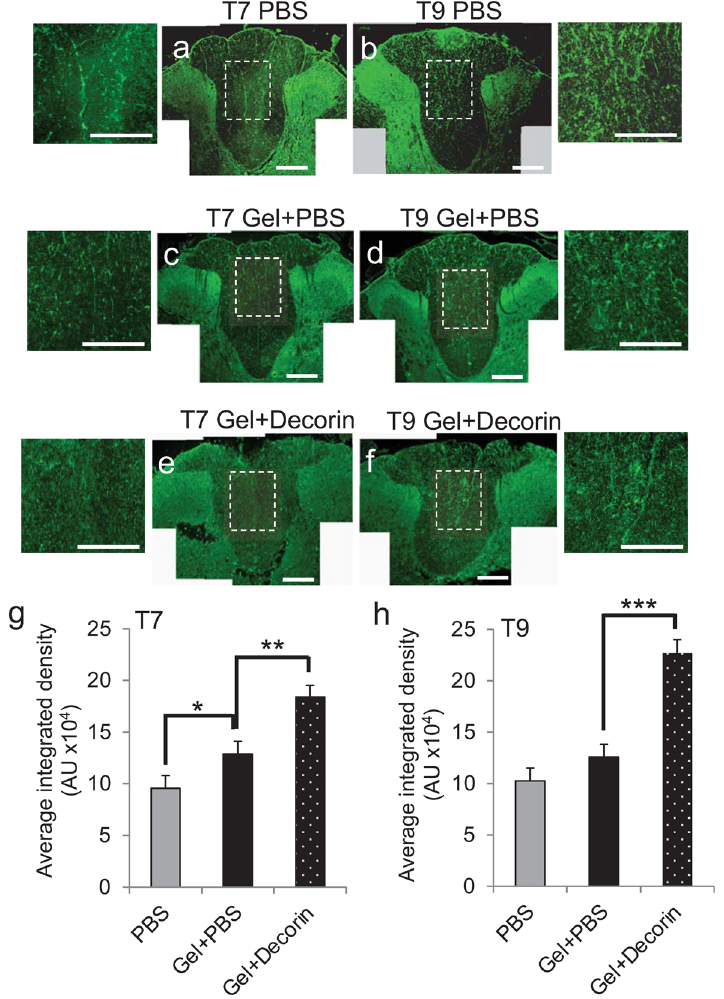
Figure 7. Gel + Decorin promotes sparing of axons above and below the lesion site. NF200 + axons after ( a ) and ( b ) PBS treatment, ( c ) and ( d ) Gel + PBS treatment, ( e ) and ( f ) Gel + Decorin in T7 and T9 cord segments, respectively. Quantification of NF200 + axons at ( g ) T7 and ( h ) T9 to show significant axon sparing in Gel + Decorin versus Gel + PBS treatment above and below the lesion site. Gel + PBS treatment alone also promoted significant sparing below the lesion site at T7, when compared to PBS treatment alone (g). High power insets show more detail of the spared axons in the DC. Scale bars in ( a )–( f ) = 200 µm, insets to ( a )– ( f ) = 100 µm. * P < 0.05; ** P < 0.001, ** P < 0.0001, one-way ANOVA with Dunnett’s post hoc test. n = 4 rats/group, 3 independent repeats, total n = 12